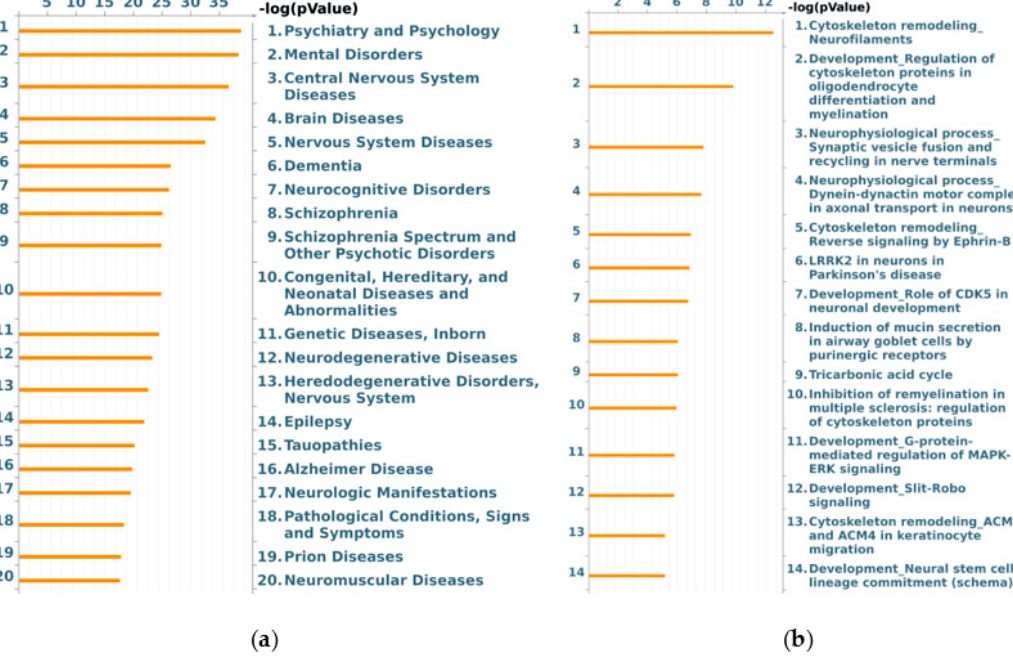
Figure 4. MetaCore “diseases by biomarkers” ( a ) and “process networks” ( b ) enrichment analysis of murine NAGLU − / − brain tissues proteome. The MetaCore enriched analysis provides a statistically supported list of (a) diseases in which identified proteins have been previously described as biomarkers; and (b) process networks more represented in identified proteins dataset.